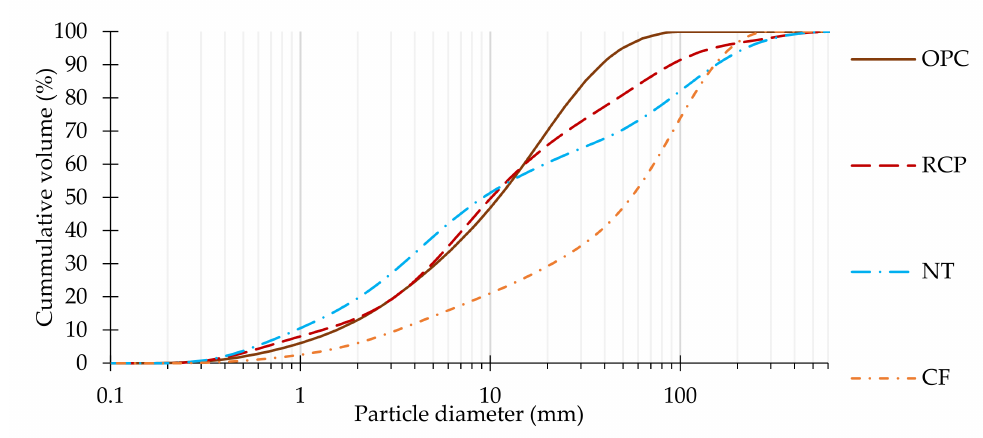
Figure 3. Particle size distribution of the cements and